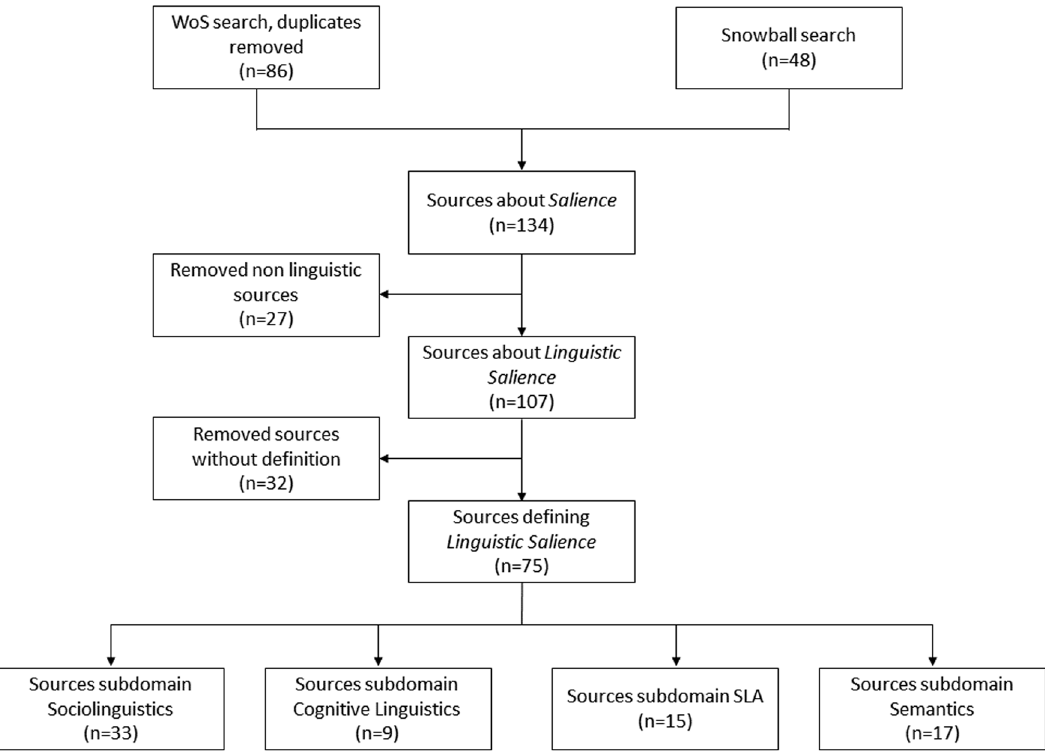
Figure 1: The selection of relevant